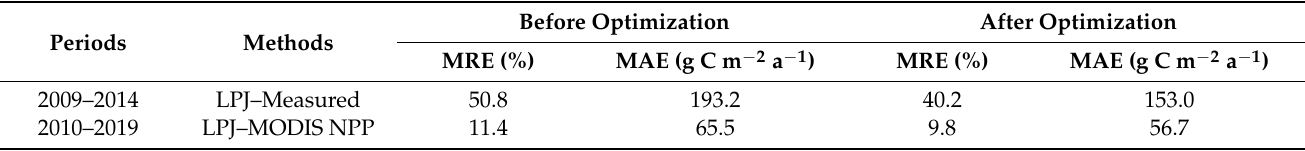
Table 4. Table of precision evaluation for annual mean